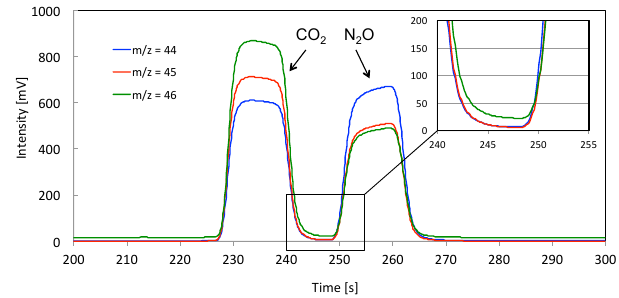
Figure 4. Chromatogram showing the separation of CO 2 from N 2 O in the artificially prepared mixture. The sample was injected to the analytical system at 60s. CO 2 appeared on chromatogram at 220– 243s and N 2 O appeared at 248–275s. Peaks are well separated, the interval between the CO 2 and N 2 O peaks is 5s. The air peak (nor- mally visible at 180–210s) is not included on this chromatogram.